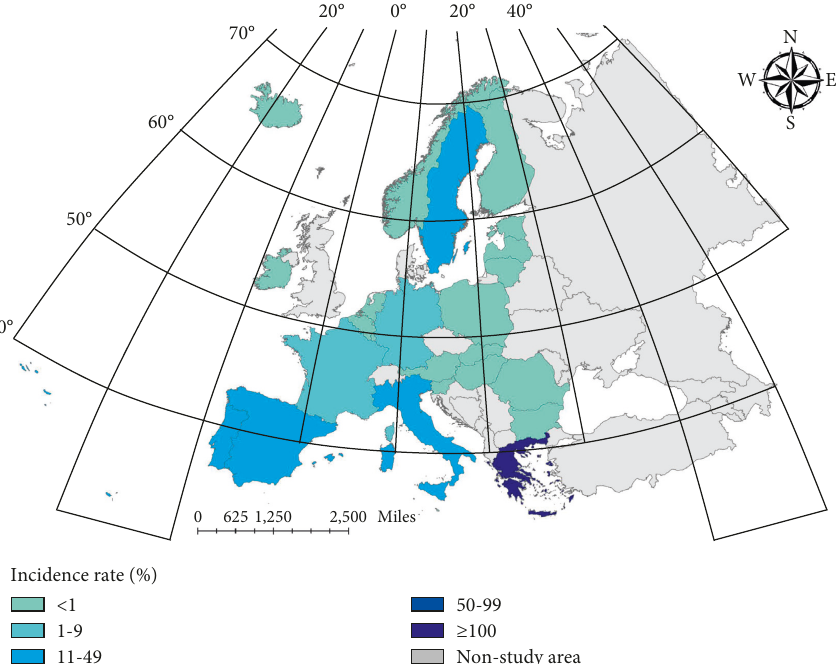
Figure 10: Spatial distribution of prediction data (LSTM).